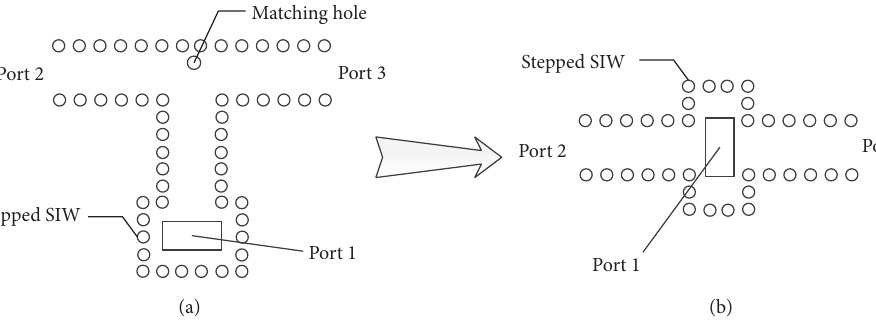
Figure 1: Configuration of the SIW antenna and the feeding network.